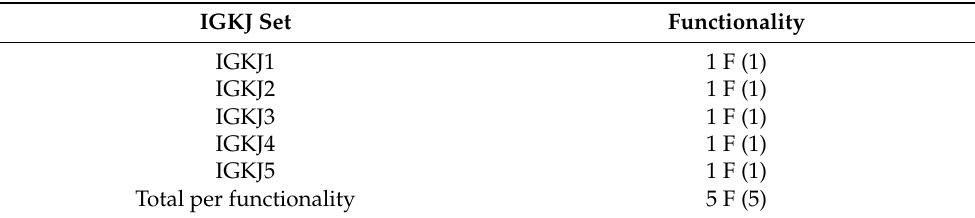
F: functional; the number of alleles is indicated in the parentheses. Data available in IMGT Repertoire (IG and TR) http://www.imgt.org/IMGTrepertoire/, accessed on 11 November 2021 > Locus and genes > Gene tables > IGKJ > Nonhuman Primates > Rhesus monkey ( Macaca mulatta ).